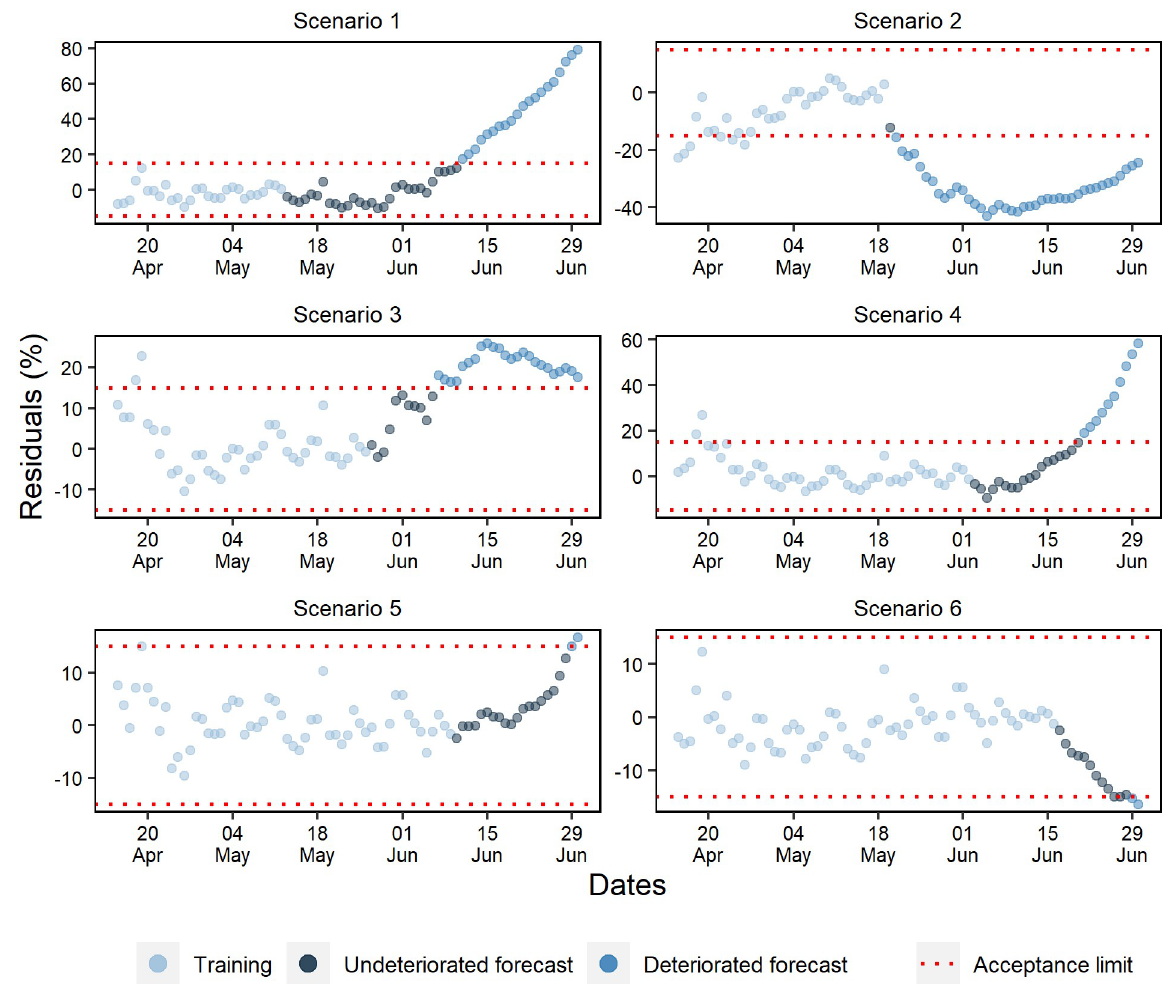
Fig 10. Percentual residuals for cumulative cases of the 6 analyzed